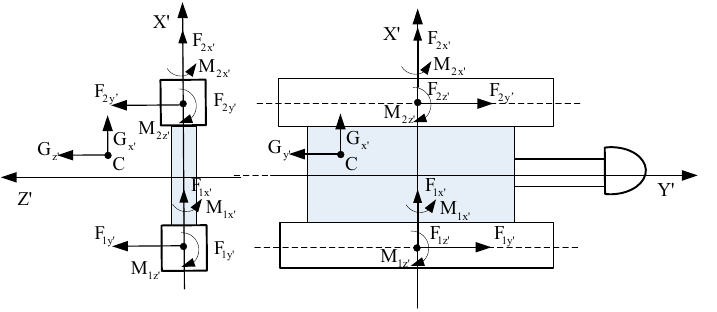
Figure 3. Dynamics diagram of roadheader’s rectification.